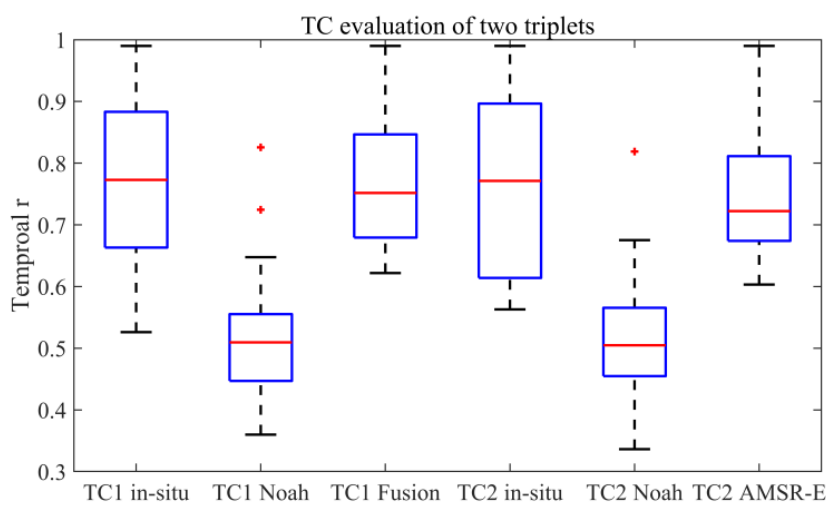
Figure 9. TC evaluations of the two triplets. TC1 indicates in situ Noah-Fusion TC triplet and TC2 indicates in situ Noah-AMSR-E TC triplet.